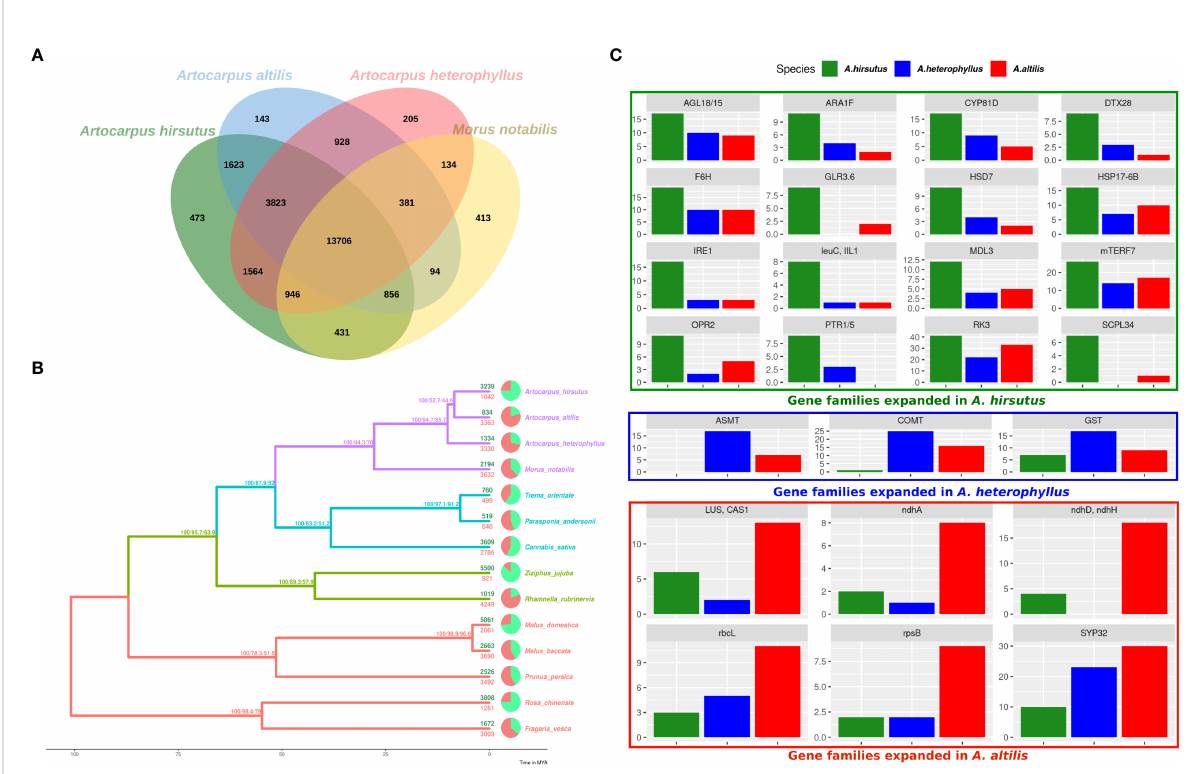
FIGURE 2 Comparative genomics of orthologous gene content evolution in Artocarpus and their relatives. (A) Orthovenn diagram of three Artocarpus species ( A. hirsutus, A. altilis, and A. heterophyllus ) with M. notabilis . Unique and shared gene clusters between these species are denoted in respective intersections. A. hirsutus has 473 unique gene clusters not shared with other congenerics. (B) Representative species tree with gene family evolution or Gene gain-losses: 14 species from Order Rosales of family Moraceae (purple), Rhamnaceae (sea green), Cannabaceae (olive green), and Rosaceae (red) are represented in the species tree based on ~4500 orthologous genes. Branch values are bootstraps values, gCF (gene concordance factors) and sCF (site concordance factors), respectively. Pie charts and associated numbers at the tips show gene families ’ expansions (green) and contractions (red). (C) Signi fi cantly expanded gene families in A. hirsutus (green), A. heterophyllus (blue), and A. altilis